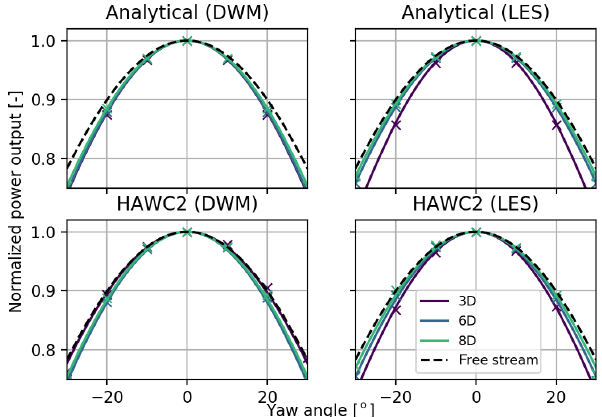
Figure 6. Power–yaw loss exponent as a function of turbine spacing for the four power calculation methods presented in this investiga-